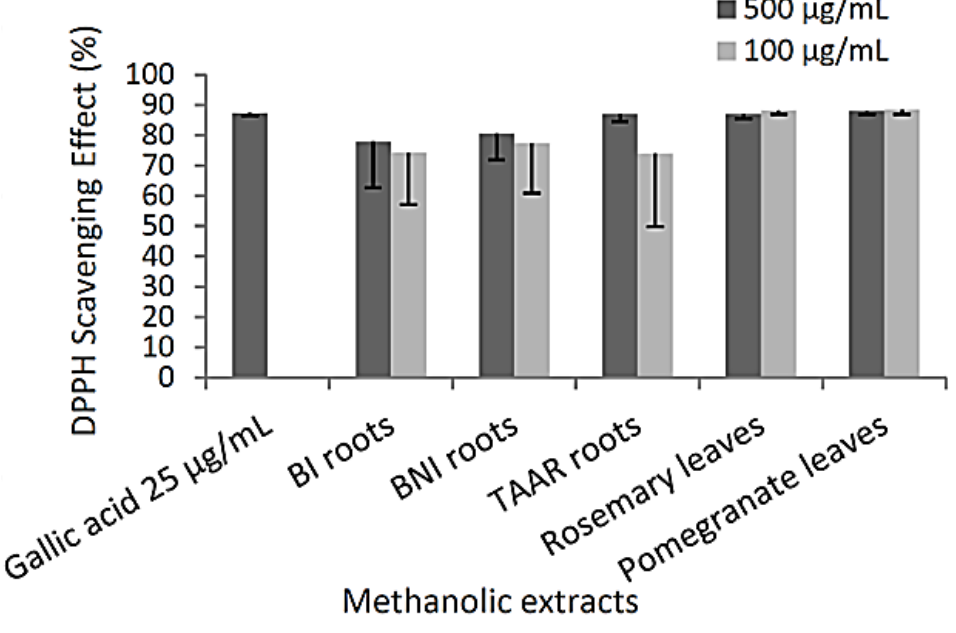
Figure 1. DPPH radical scavenger activity of methanolic extracts. The data are presented as mean (SD) values for each experimental condition (n = 3), and a nonparametric Mann–Whitney test analysis was used to compare the statistical differences between extracts.